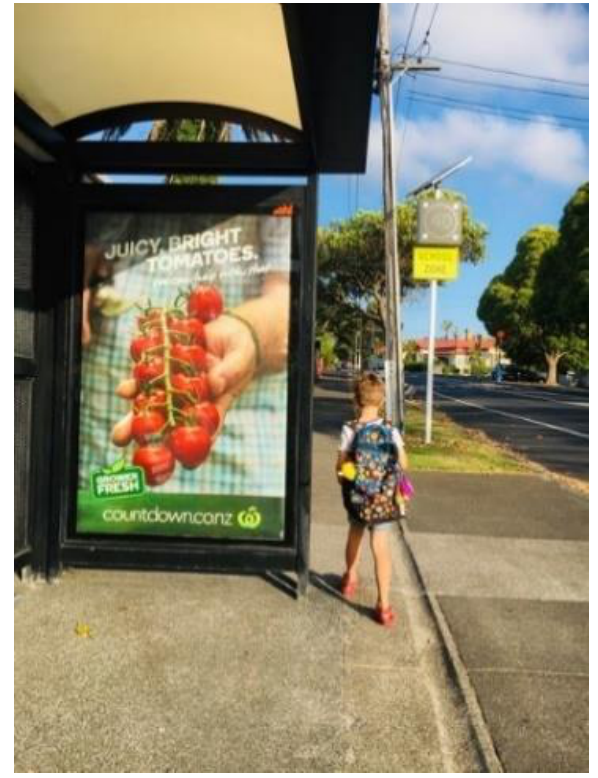
Figure 1. Child standing next to a typical bus stop.